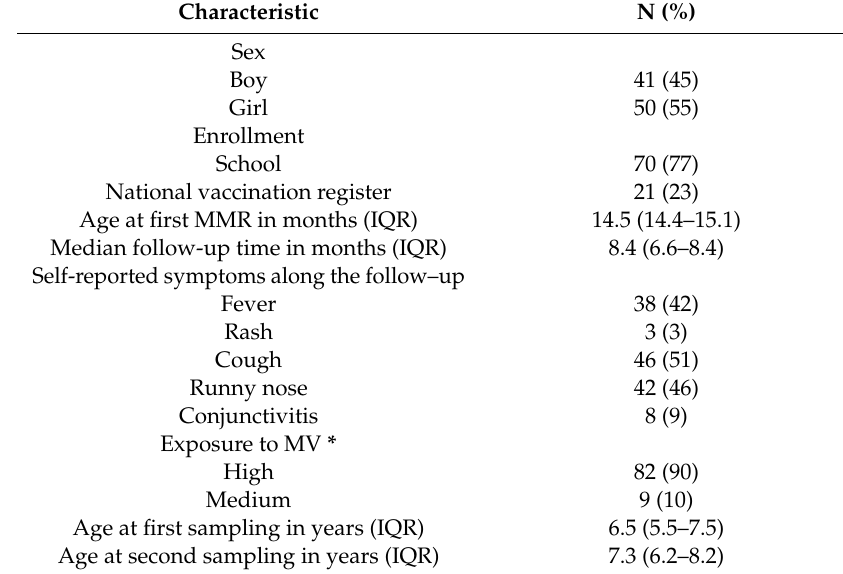
Table 1. Characteristics of once-vaccinated participants ( n = 91) included in an observational cohort study to assess correlates of protection against measles, the Netherlands,